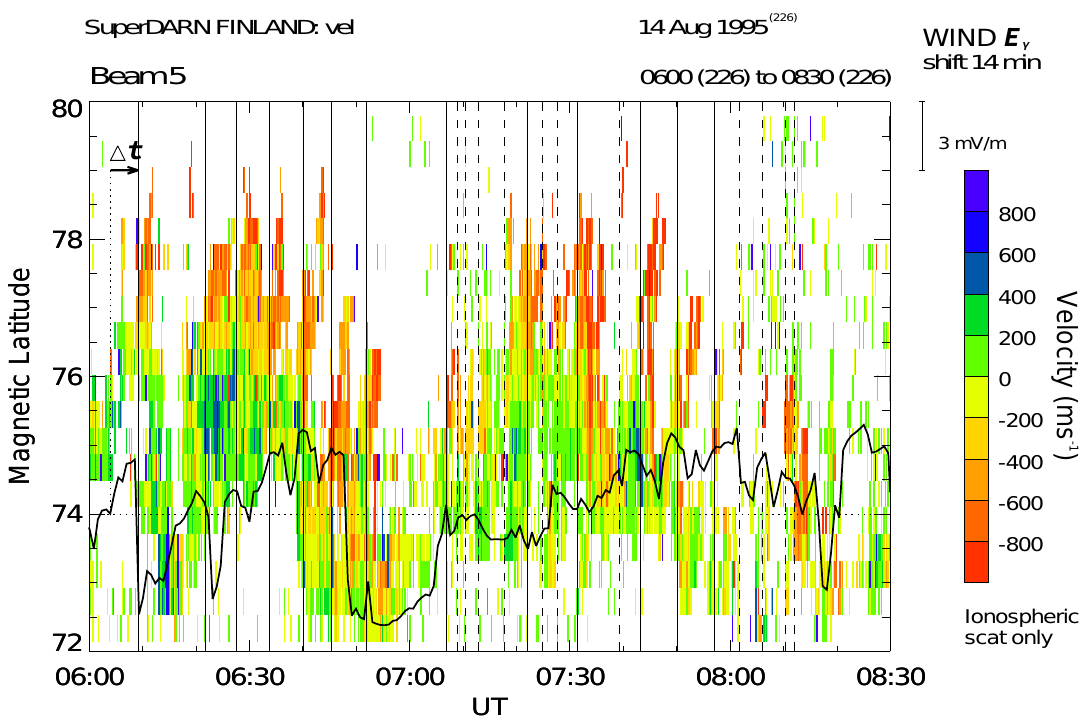
Fig. 8. Finland radar high resolution line-of-sight velocity data. The color-coded velocity (beam 5) shows quasi-periodic poleward pro- gressing PIFs. The dawn-dusk electric field E Y is superposed, shifted by 14min. The solid/broken vertical lines show the onset times of major/minor PIFs and the horizontal arrow indicates the inferred delay ( 1t ) of the reconnection onset after the IMF southward turning at the